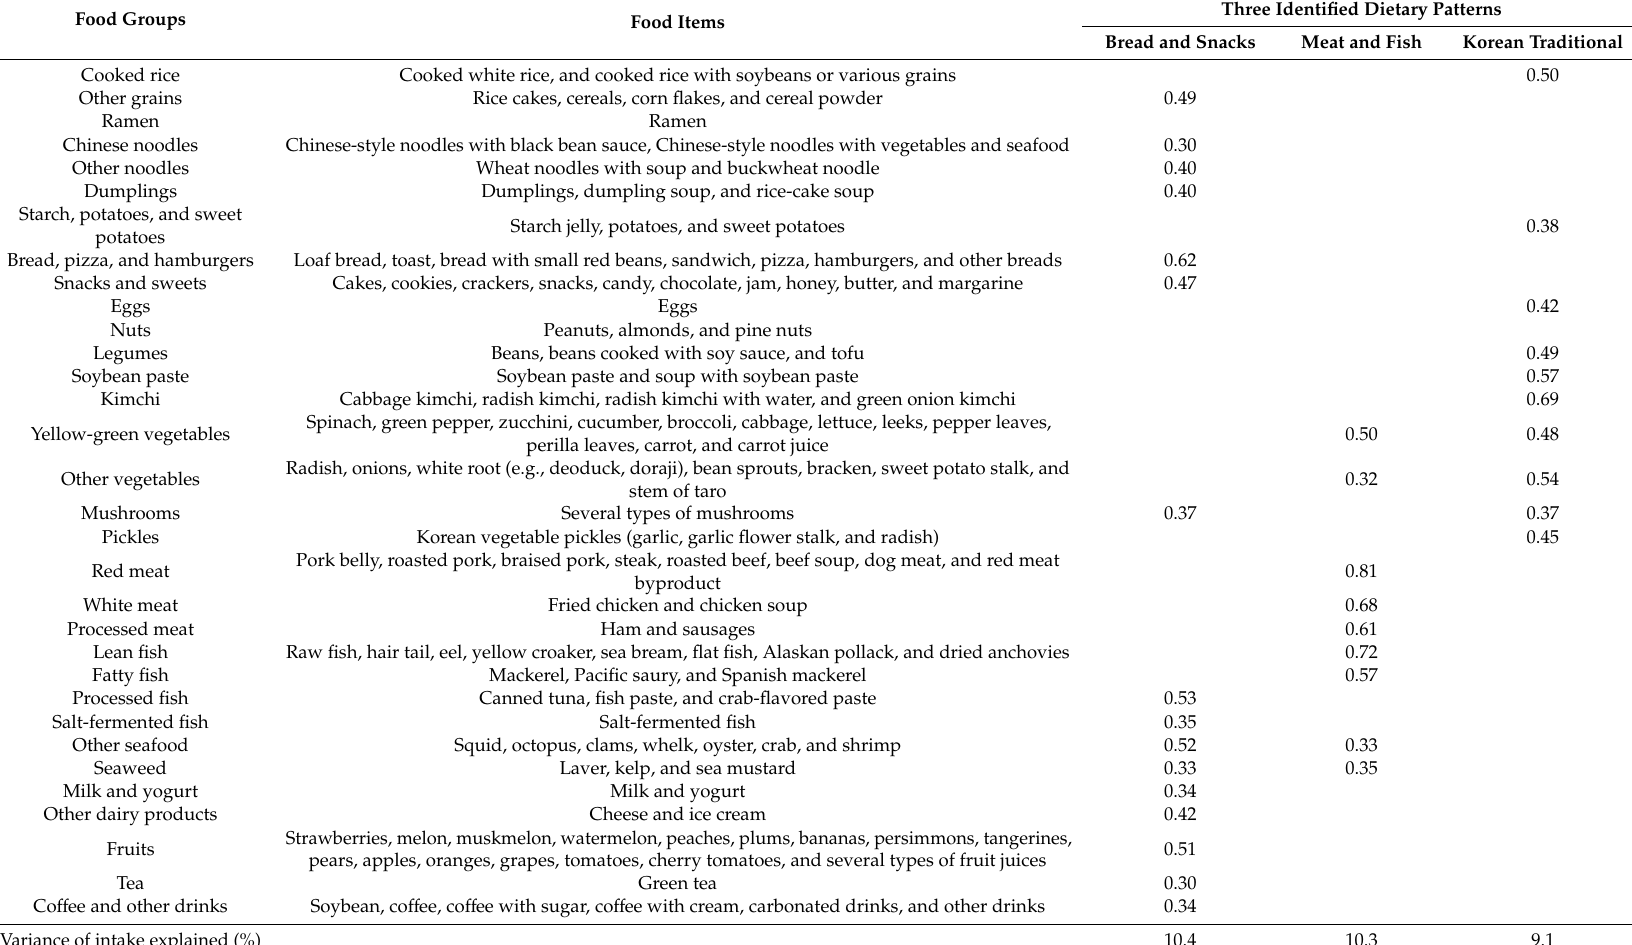
Table 1. Food groups and items from semiquantitative FFQ for dietary patterns and rotated factor loadings a of the identified three dietary patterns. Food